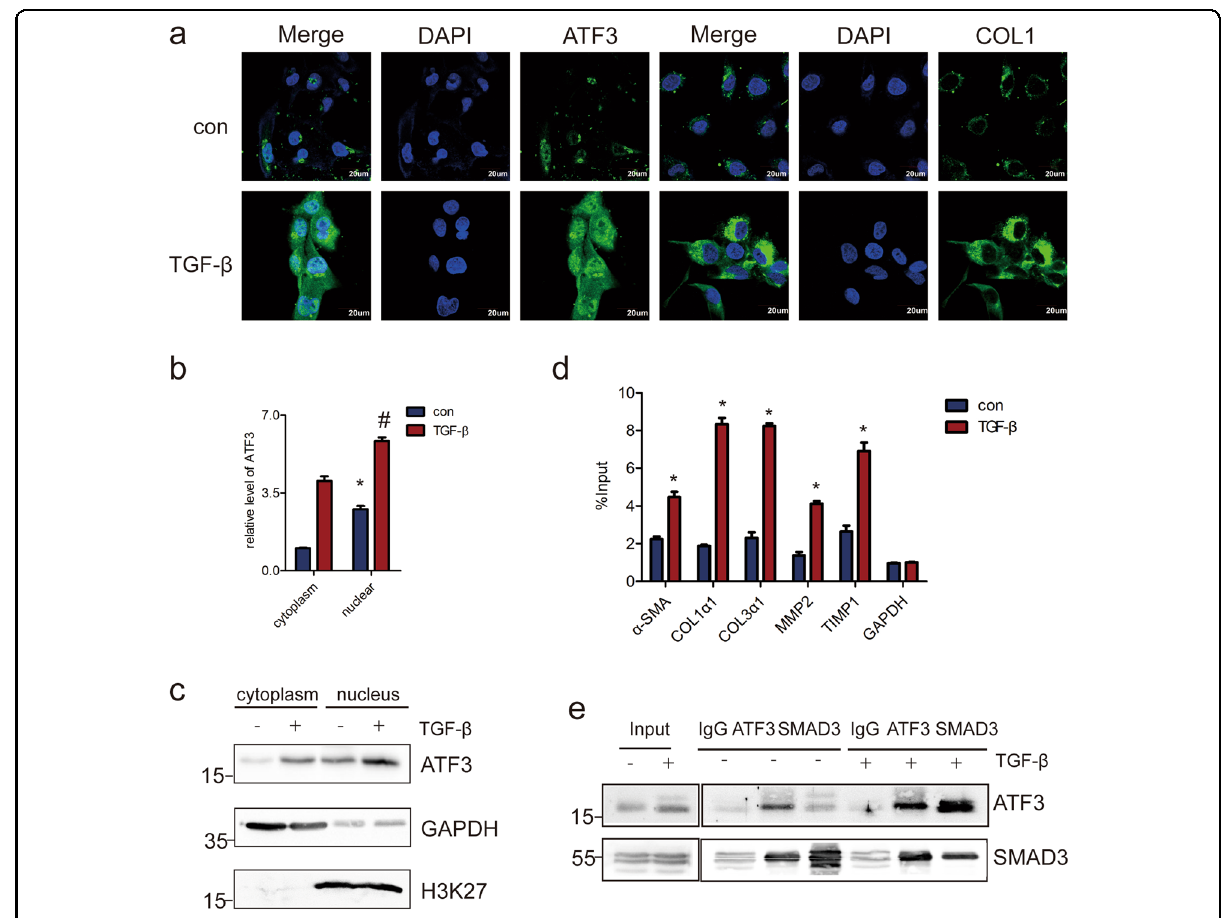
Fig. 5 ATF3 translocates to the nucleus of LX-2 cells and promotes the transcription of pro- fi brogenic genes. a LX-2 cells were treated with 10 ng/ml TGF- β for 48 h, and the expression and location of ATF3 and COL1 were determined by confocal microscopy. DAPI-stained nuclei blue; scale bar, 20 μ m. b , c The RNA and protein were extracted from the nuclei or cytoplasm of LX-2 cells treated with or without TGF- β , the expression of ATF3 was assessed by qRT-PCR and western blot. GAPDH was used as control in cytoplasm and H3K27 as nuclear. d LX-2 cells were treated with TGF- β and ChIP analyses were performed on indicated genes promoter regions, using anti-ATF3 antibody. Enrichment was shown relative to input. e ATF3 and SMAD3 antibodies were used for co-immunoprecipitation (IP) with LX-2 lysates treated with or without TGF- β . The data were expressed as the mean ± SEM for at least triplicate experiments. GAPDH was used as an internal control; */# p <